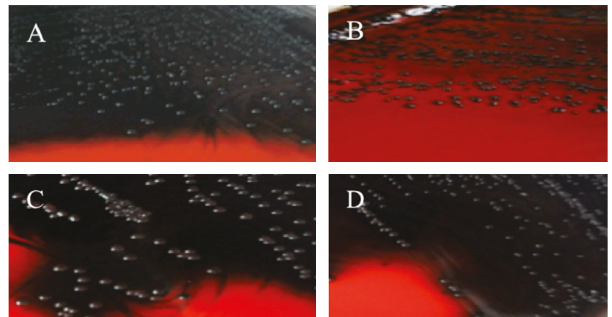
Figure 1: CRA plate test. Black colonies of the slime-producing S. aureus : (A) S. aureus 4E; (B) S. aureus 9; (C) S. aureus 13; (D) S. aureus 19. Table 3: icaADBC genes in Staphylococcus aureus isolates from food contact surfaces. Strain Number of isolates S. aureus (SA1–SA84) SA � S. aureus . Table 4: Association between the biofilm phenotype on Congo red agar, slime production, adherence assay, and the presence of icaADBC genes in Staphylococcus aureus . Bacterial